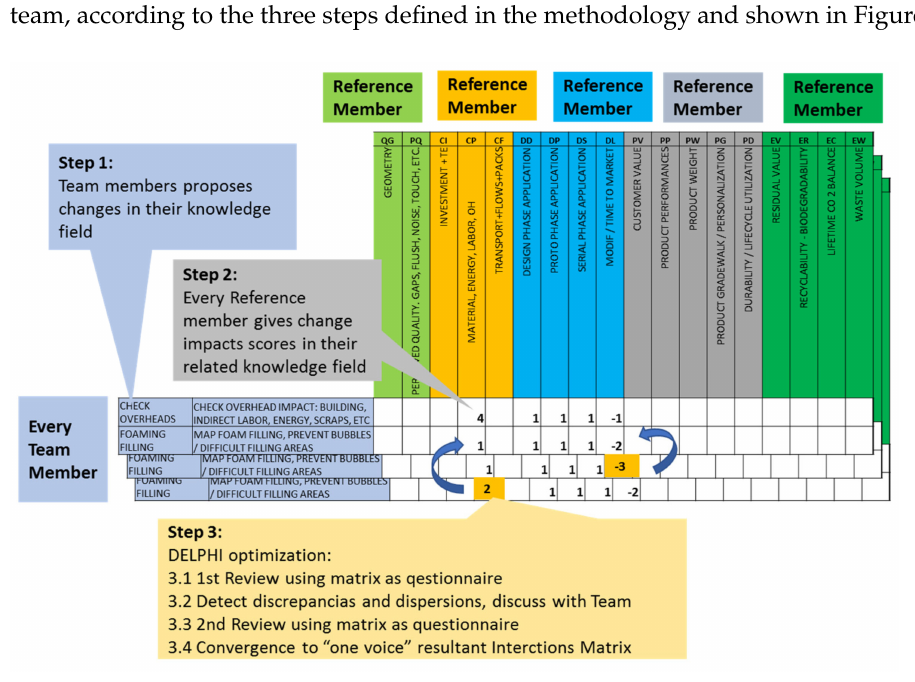
Figure 5. Interaction matrix development steps schema.